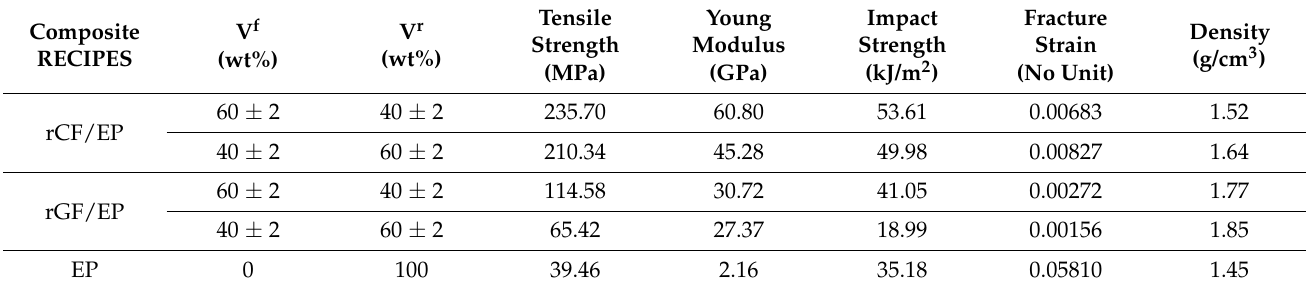
Table 1. Experimental results of the compression moulded recycled composites